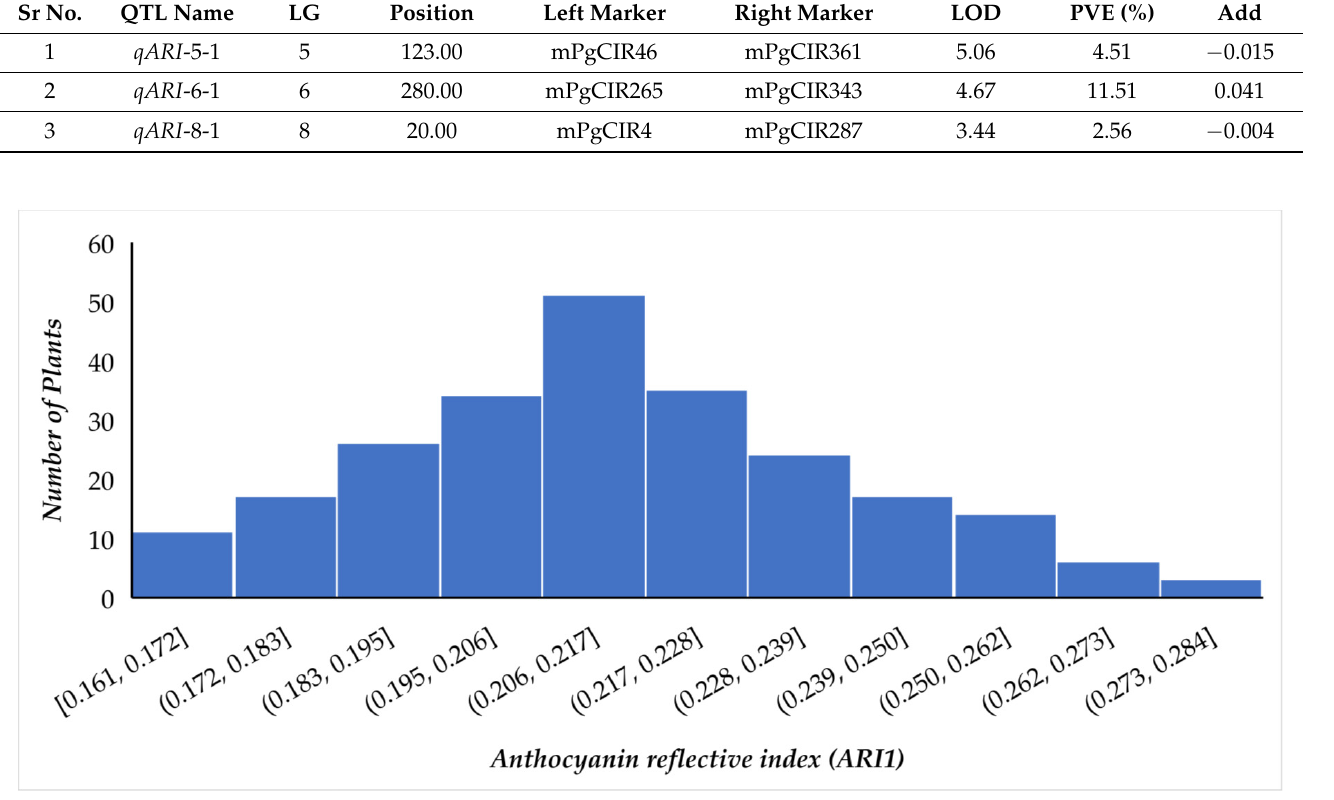
Figure 4. SSR-based linkage map of guava (AS × PG), and distribution of QTLs controlling antho- cyanin trait.